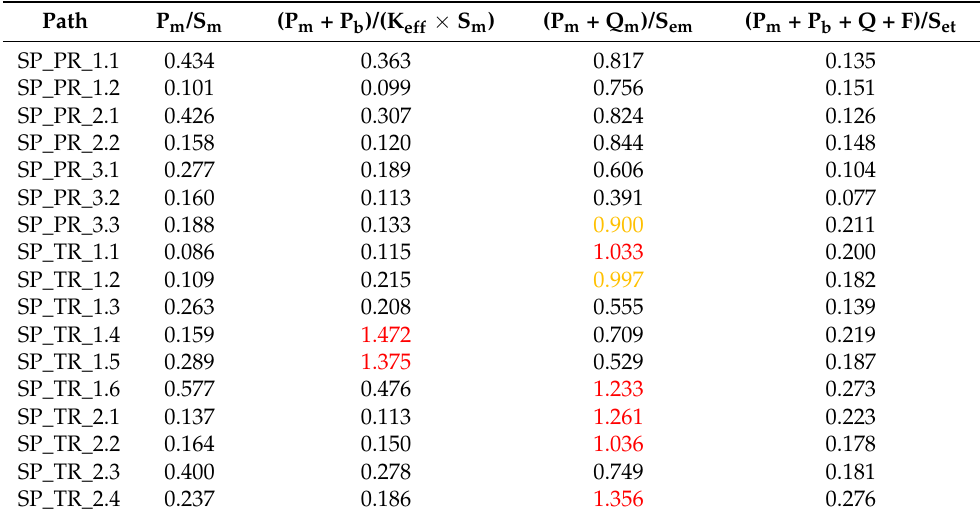
Table 12. RCC-MRx Level A criteria verification within SPs